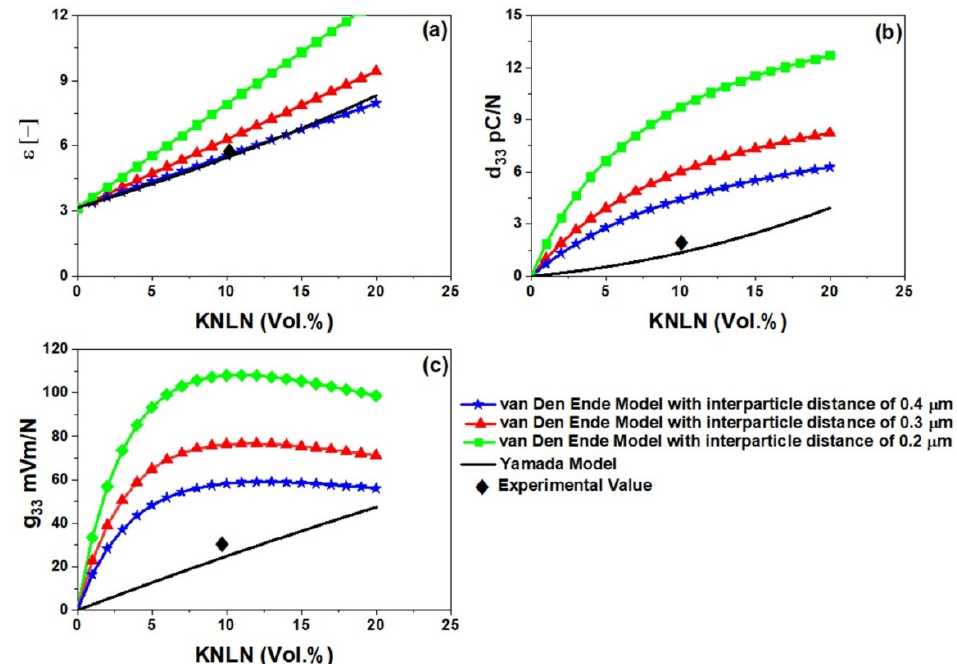
Figure 8. Calculated values of piezoelectric properties using van Den Ende (for composites with aligned particles) and Yamada (for composite with random orientation of particles) model: ( a ) dielectric constant ( ε r ); ( b ) piezoelectric charge coefficient (d 33 ); and ( c ) piezoelectric voltage sensitivity (g 33 ).